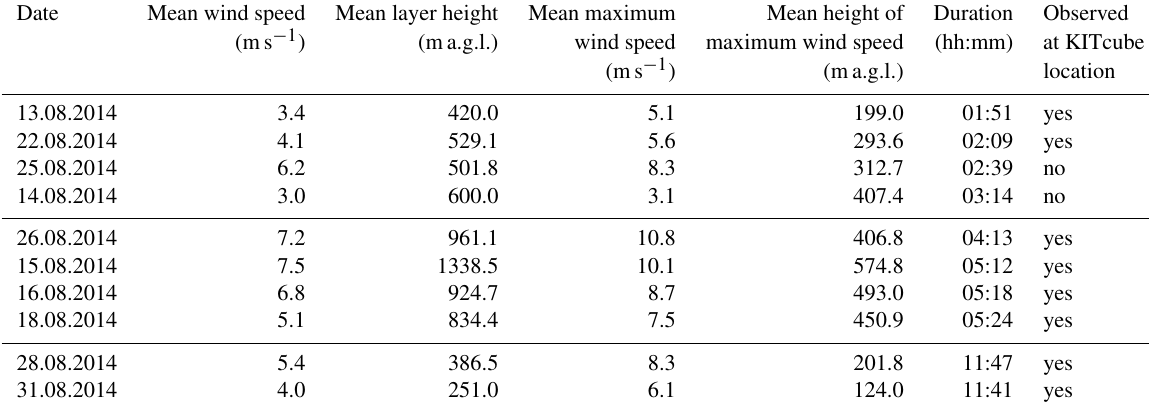
Table 1. Characteristics of the foehn events derived from RHI scans at 299 ◦ (dashed line in Fig. 1a). Presented are mean wind speed, mean height, mean maximum wind speed, and mean height of the wind speed maximum of the foehn events. The mean wind speed was first calculated for each RHI scan and then averaged over the whole event. The height, maximum wind speed, and height of the wind speed maximum were determined for each RHI scan and then also averaged over the whole duration of the event. The events are sorted according to their duration. Mean layer height Mean maximum Mean height of